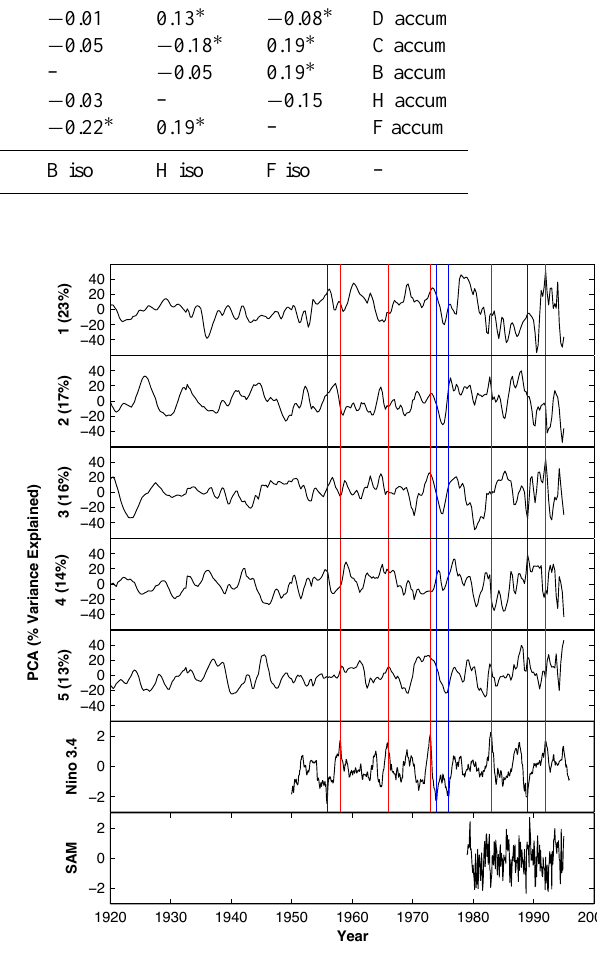
Figure 5. The first 5 principal components of the shallow ice core δ D records are compared with the Niño 3.4 and SAM indexes. Strong El Niño years (red lines) and strong La Niña years (blue lines) are defined as 5 consecutive months greater than or less than 1.5 ◦ C sea surface temperature anomalies for the Niño 3.4 region,